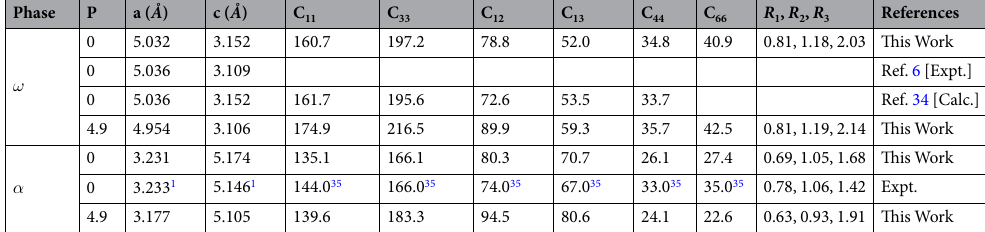
Table 1. Calculated lattice and elastic constants for the ω and α phases of Zr at P = 0 and 4.9 GPa. Elastic constant values are in GPa. The elastic anisotropy ratio for the HCP metals is given by ref. 61: = + − R C C C